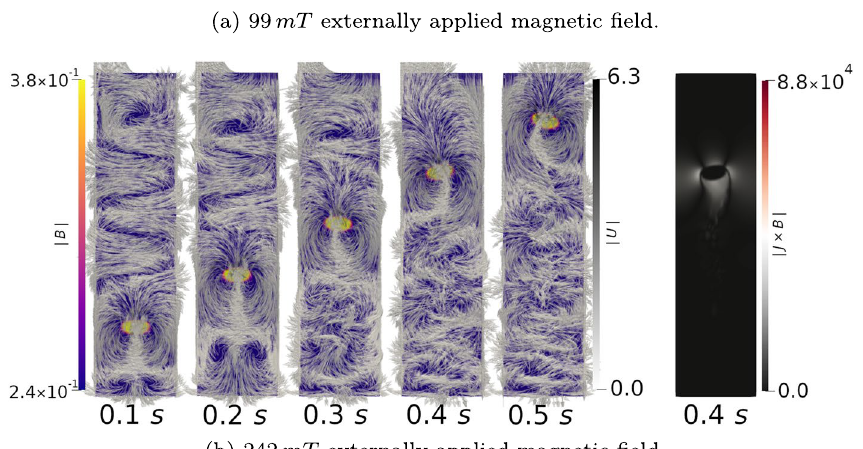
Figure 3. Simulated single Ar bubble rise through Ga–In–Sn liquid with 99 mT and 242 mT applied magnetic field with | B | and U vectors. The simulated behaviour of the system strongly agrees with that observed experimentally. With no applied magnetic field, the bubble rises and instabilities develop causing oscillations. As the magnitude of the applied horizontal magnetic field is increased, the Lorentz force, J × B , dampens out the magnitude of these instabilities to a greater degree, until at 505 mT the bubble rises through the liquid metal almost perfectly linearly. Animations of these simulations accompany this work, and show this oscillation very clearly.